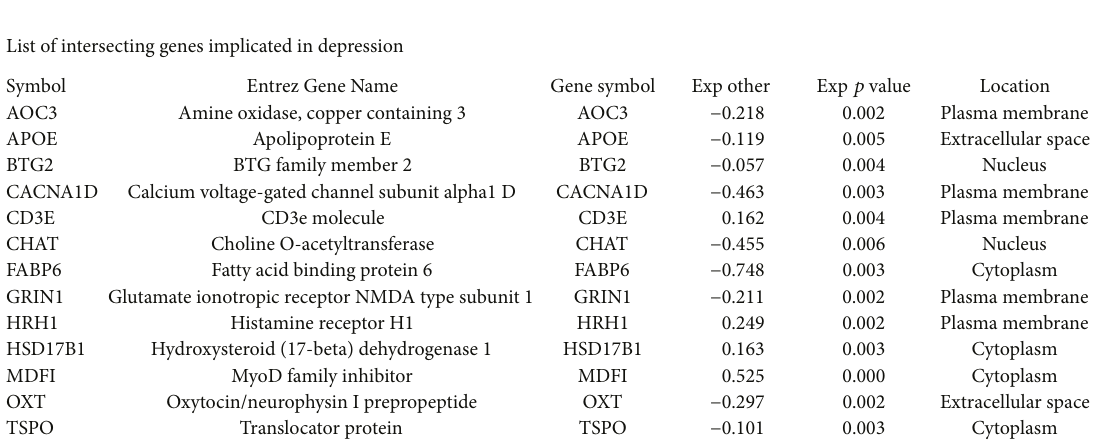
Figure 2: Venn diagram of genes involved in depression with signi fi cant di ff erential methylation. This fi gure shows a set of 13 genes identi fi ed from our dataset with signi fi cant di ff erential methylation resulting from citalopram treatment overlapping with a curated list of genes implicated in psychological depression according to the current IPA database, shown in Venn diagram form. Genes are classi fi ed according to their subcellular location, p value, and expression value where positive expression values indicate upregulation and negative expression values represent downregulation. A few important genes included in this list are OXT, GRIN1, CHAT, and CACNA1D which are potential regulators of neurophysiological processes and have a high degree of implication in psychological